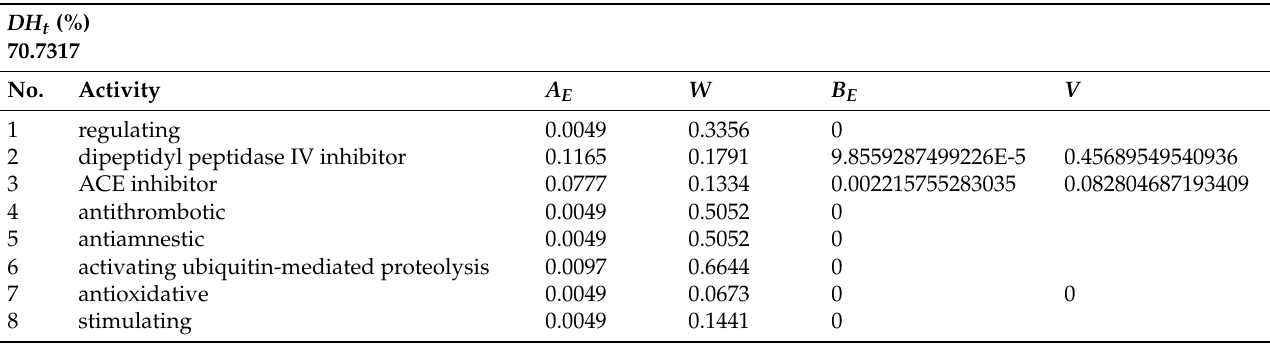
Table A50. A E , DH t , W , B E and V values from RubisCO of Halophila stipulacea . In silico enzymatic cleavage carried out by using pepsin (pH > 2).